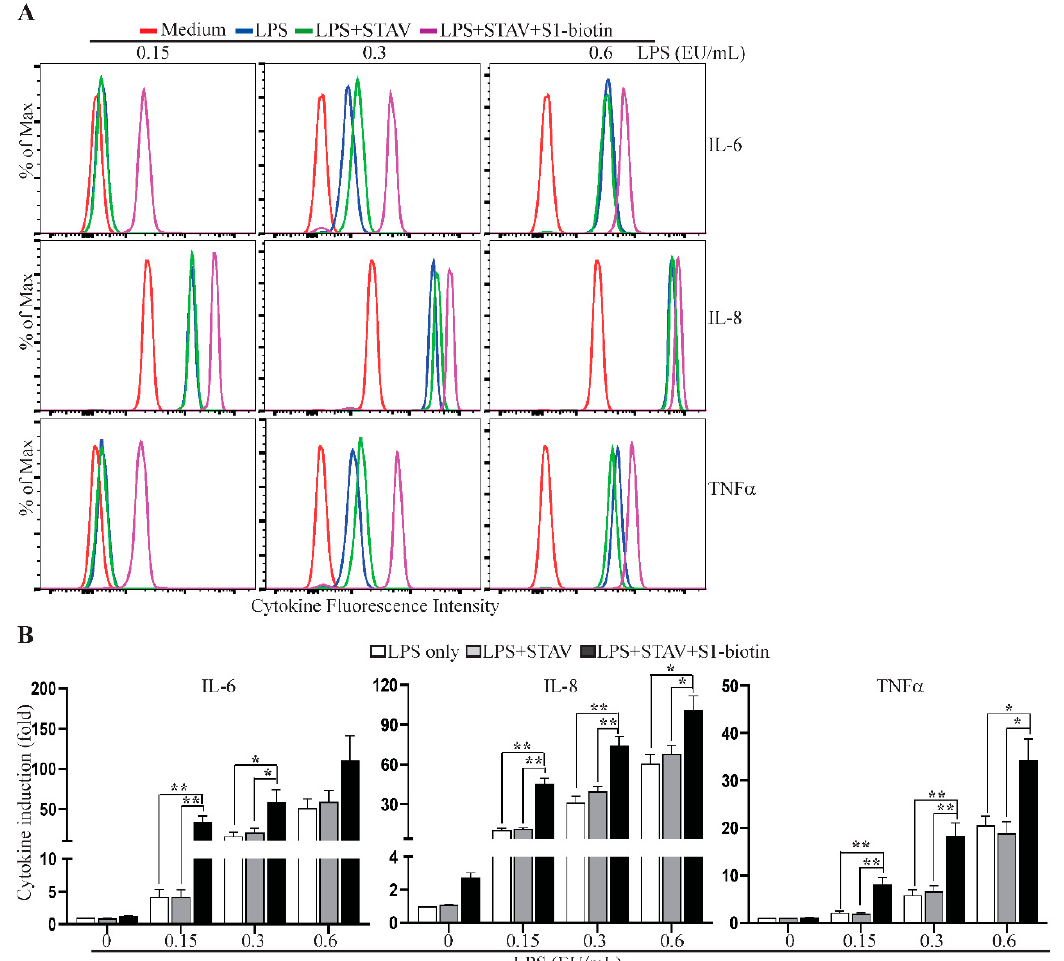
Figure 6. Spike protein captures endotoxin to induce cytokine expression. Rested PBMC were cultured for 3 h in wells, which were coated with or without 100 µL of streptavidin (STAV, 2.0 µg/mL) and S1-biotion from Vendor #1 together with 0.15, 0.3 or 0.6 EU/mL LPS. The levels of IL-6, IL-8 and TNF α in the supernatants of cultured PBMC were measured using the CBA human inflammatory cytokine kit and flow cytometric analysis. The concentrations of IL-8 in the supernatants were also measured using an ELISA kit. Data shown in ( A ) are representative of the flow cytometric results from four healthy donors, and data shown in ( B ) are mean of cytokine induction indices (fold) ± SE derived from four healthy donors, which were calculated using cytokine concentrations measured by the CBA assay (IL-6 and TNF α ) or the ELISA (IL-8) and the formula: cytokine concentration of treated PBMC/cytokine concentration of untreated PBMC.. Statistical analyses were performed using two-tailed, Student’s t -test. * and ** depict p < 0.05 and 0.01, respectively.